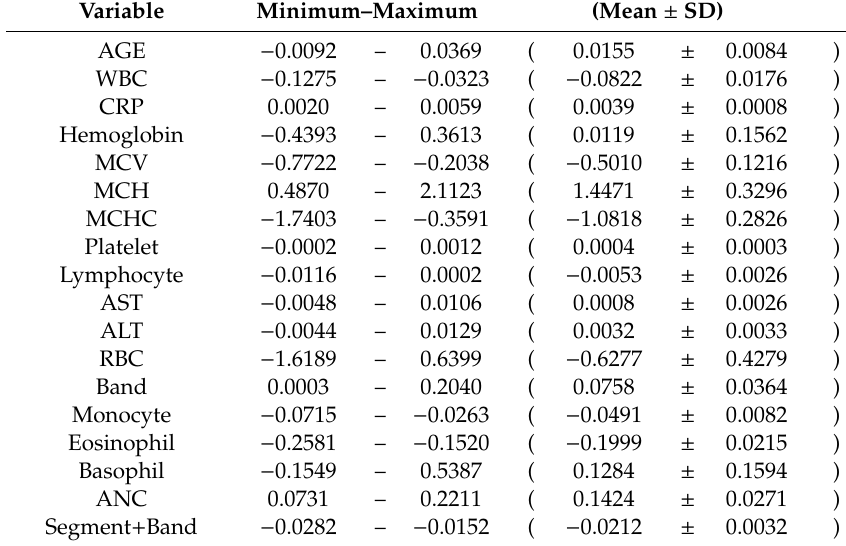
Table 2. The maximum value, minimum value, mean value, and standard deviation of logistic regression coefficients of characteristic variables .